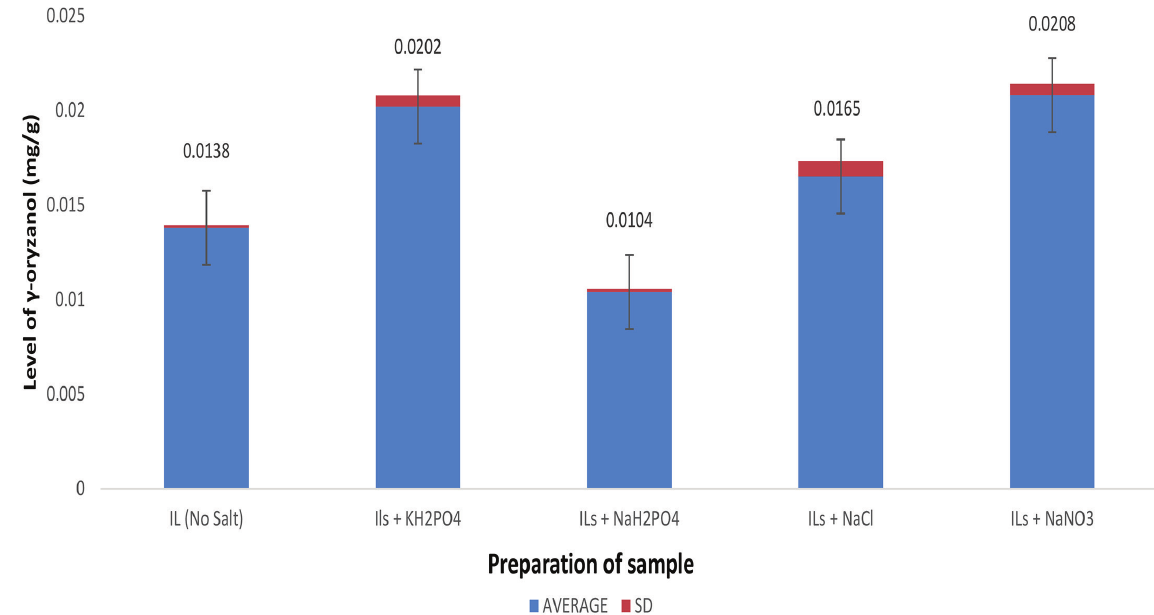
FIGURE 2 - Levels of γ-oryzanol in various